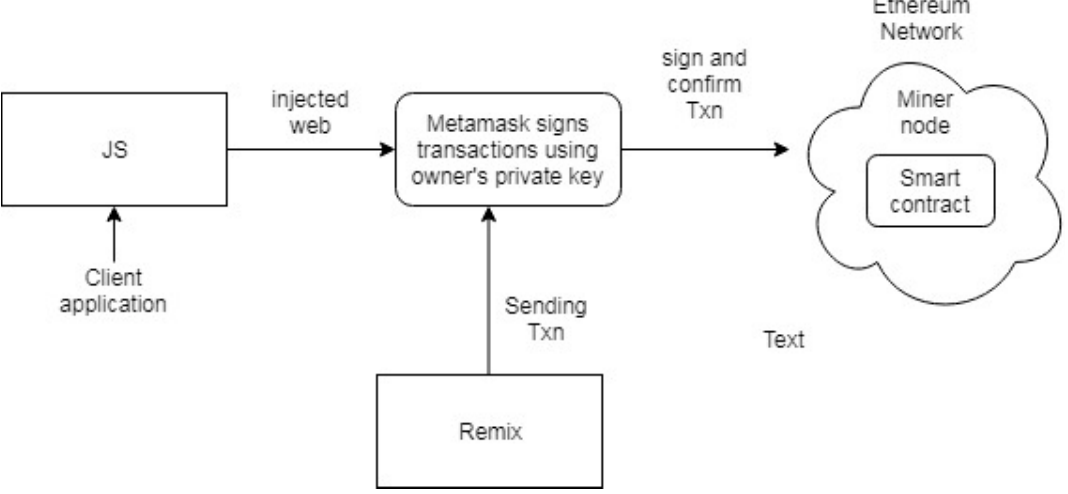
Figure 8. Ethereum transactions workflow. Energies 2019 , 12 , x FOR PEER REVIEW